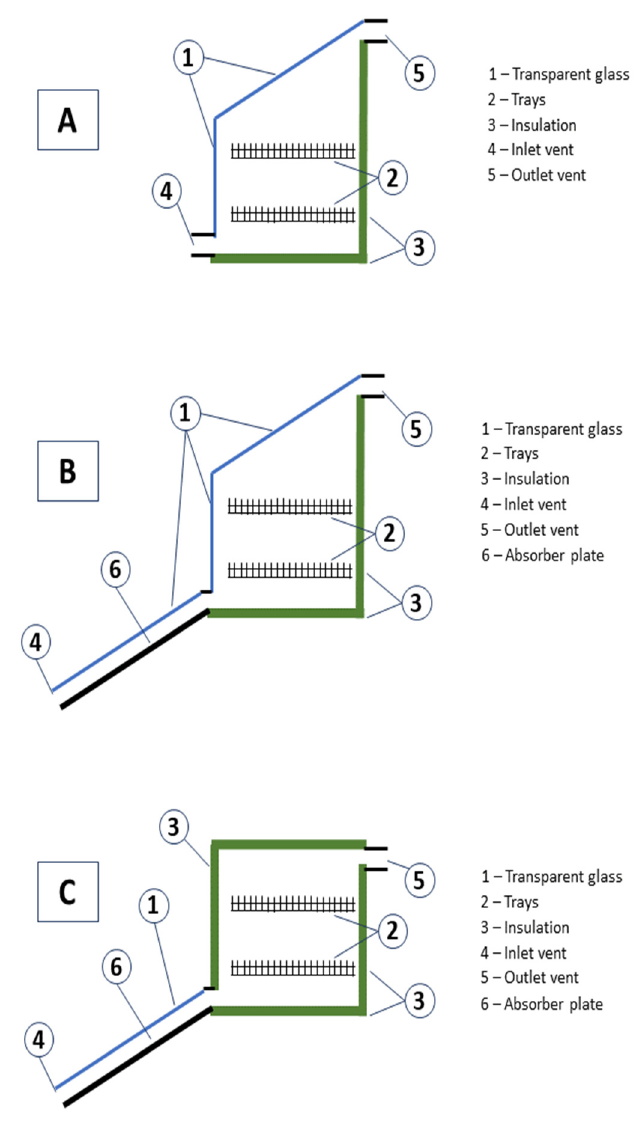
Figure 6. Sketched structure of different solar dryers (SDs).( A ) Simple SD containing trays heated by direct sunlight; ( B ) SD with external air heating pipes; ( C ) SD with no direct sunlight on the food and external air heating